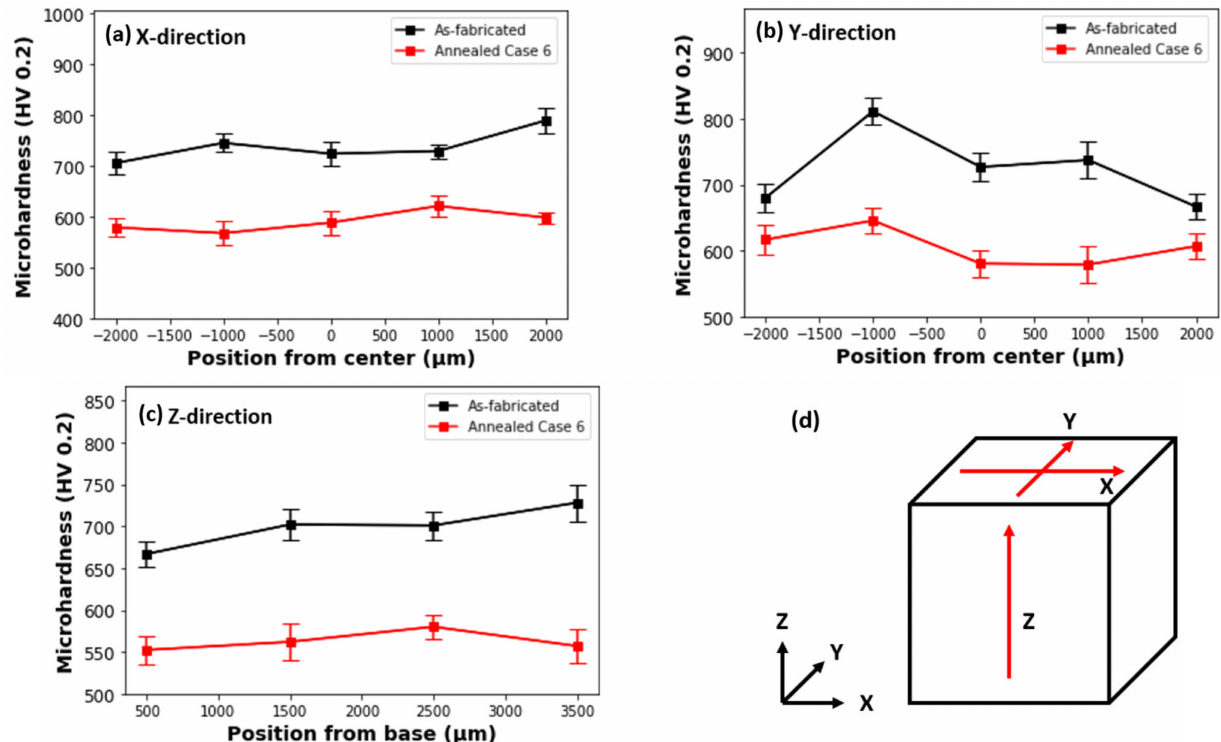
Figure 9. Comparison of microhardness between as-fabricated and annealed specimens (case 6) in the ( a ) x, ( b ) y and ( c ) z directions; ( d ) x, y and z directions.